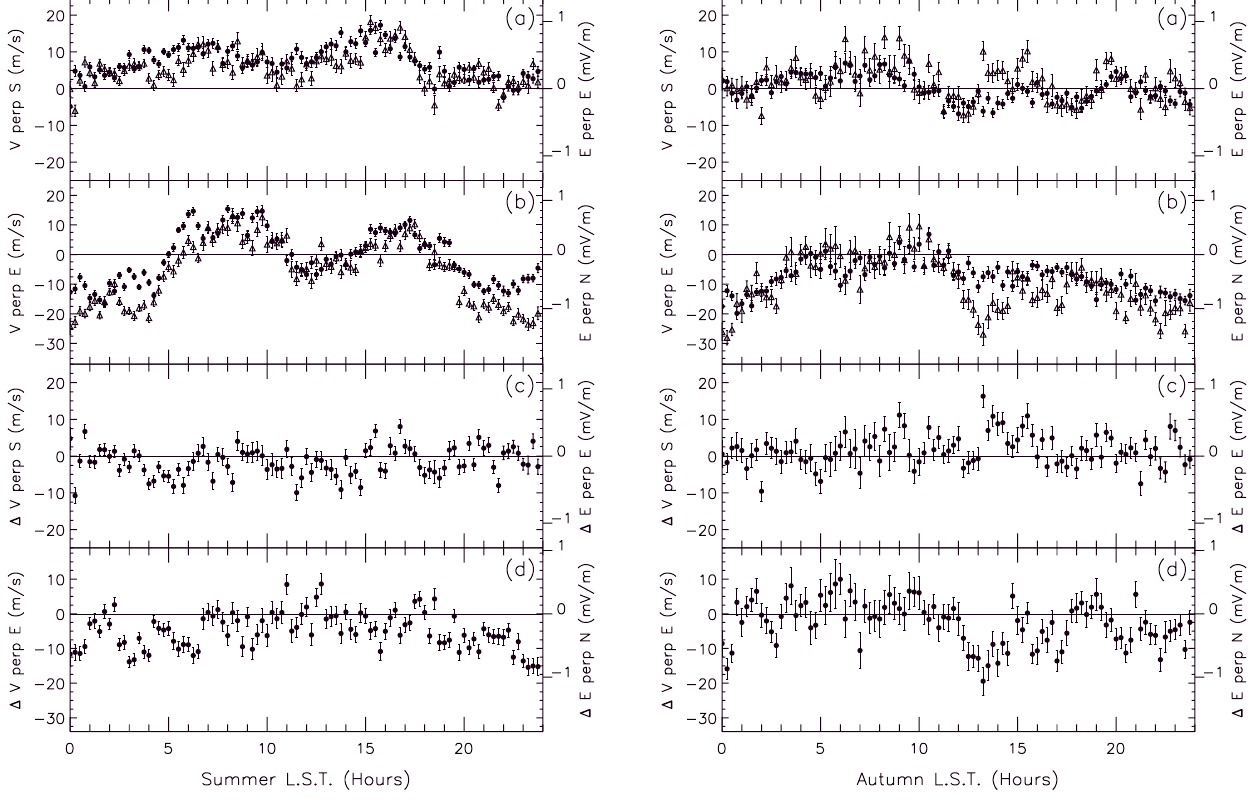
Fig. 3. The summer average diurnal variation of (a) the Doppler- velocity component V ⊥ S and (b) the component V ⊥ E . The bold dots are drifts for Kp < 3 and the triangles are drifts for Kp ≥ 3. The corresponding perturbation drifts are shown in (c) for V ⊥ S and in (d) for V ⊥ E . The error bars are standard deviations of the means. Equivalent electric field strengths are shown at right, and tick marks on the abscissa are at 1 hour intervals.